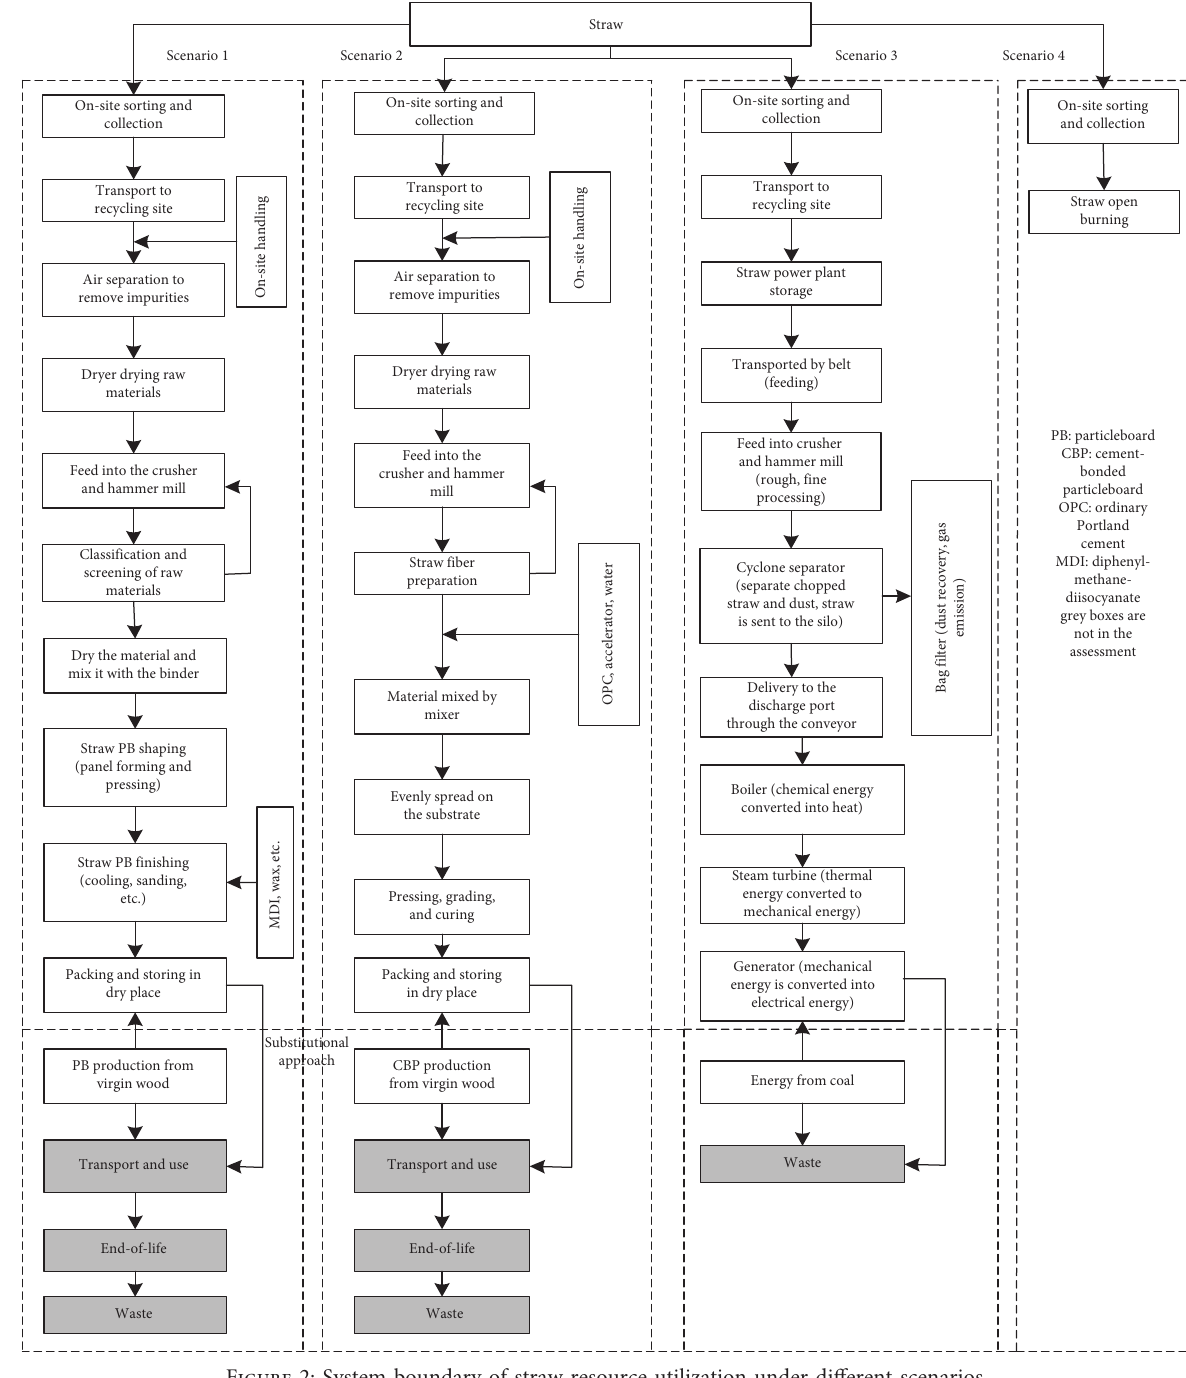
Figure 2: System boundary of straw resource utilization under different